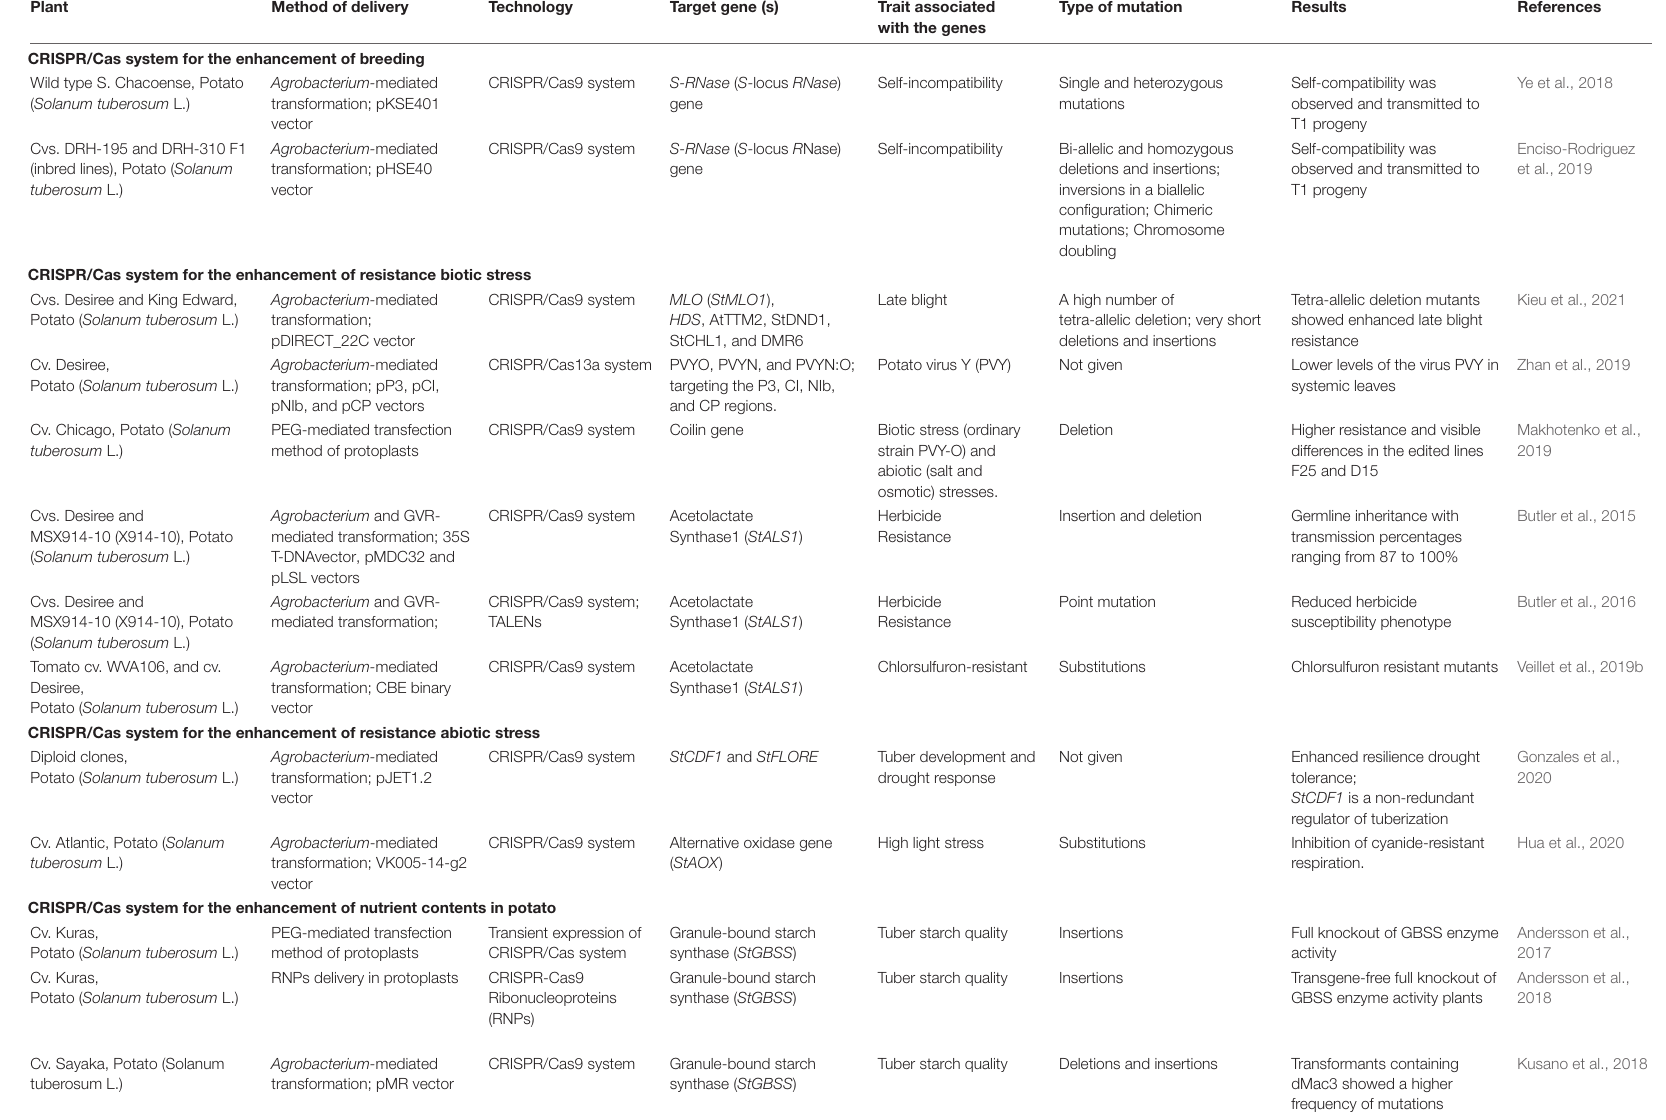
TABLE 1 | Application of CRISPR/Cas system in potato ( Solanum tuberosum L.).